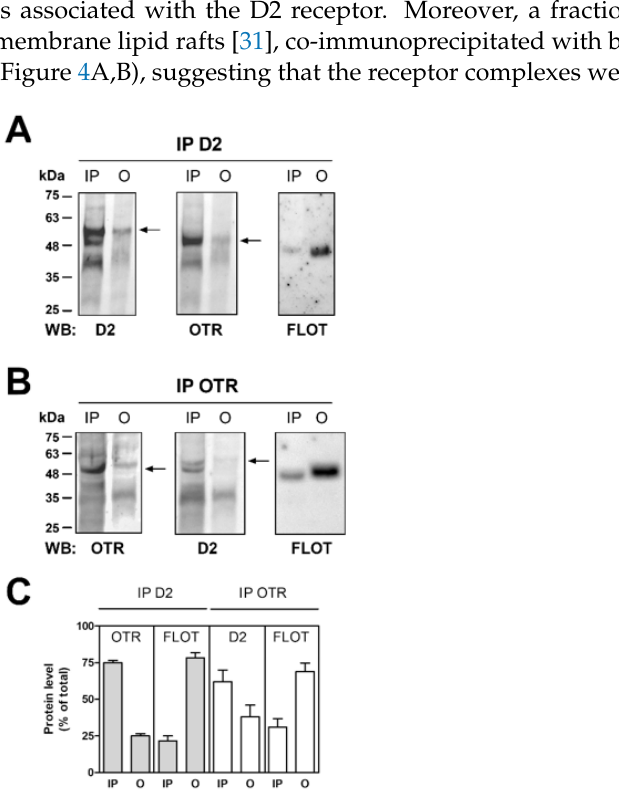
Figure 4. Co-immunoprecipitation of D2 and OT receptors in striatal gliosomes . ( A ) Aliquots (300 µg) of